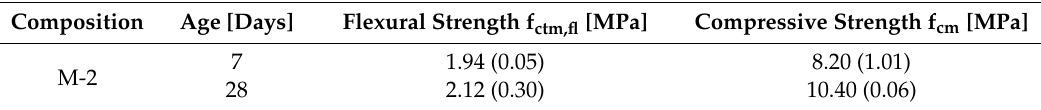
Table 8. Average mechanical properties of foam concrete M-2; standard deviations are given in parentheses.